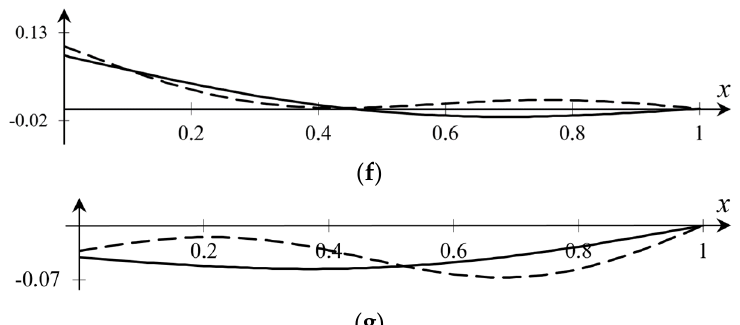
( x , t ) (dashed line) at fixed points in 2